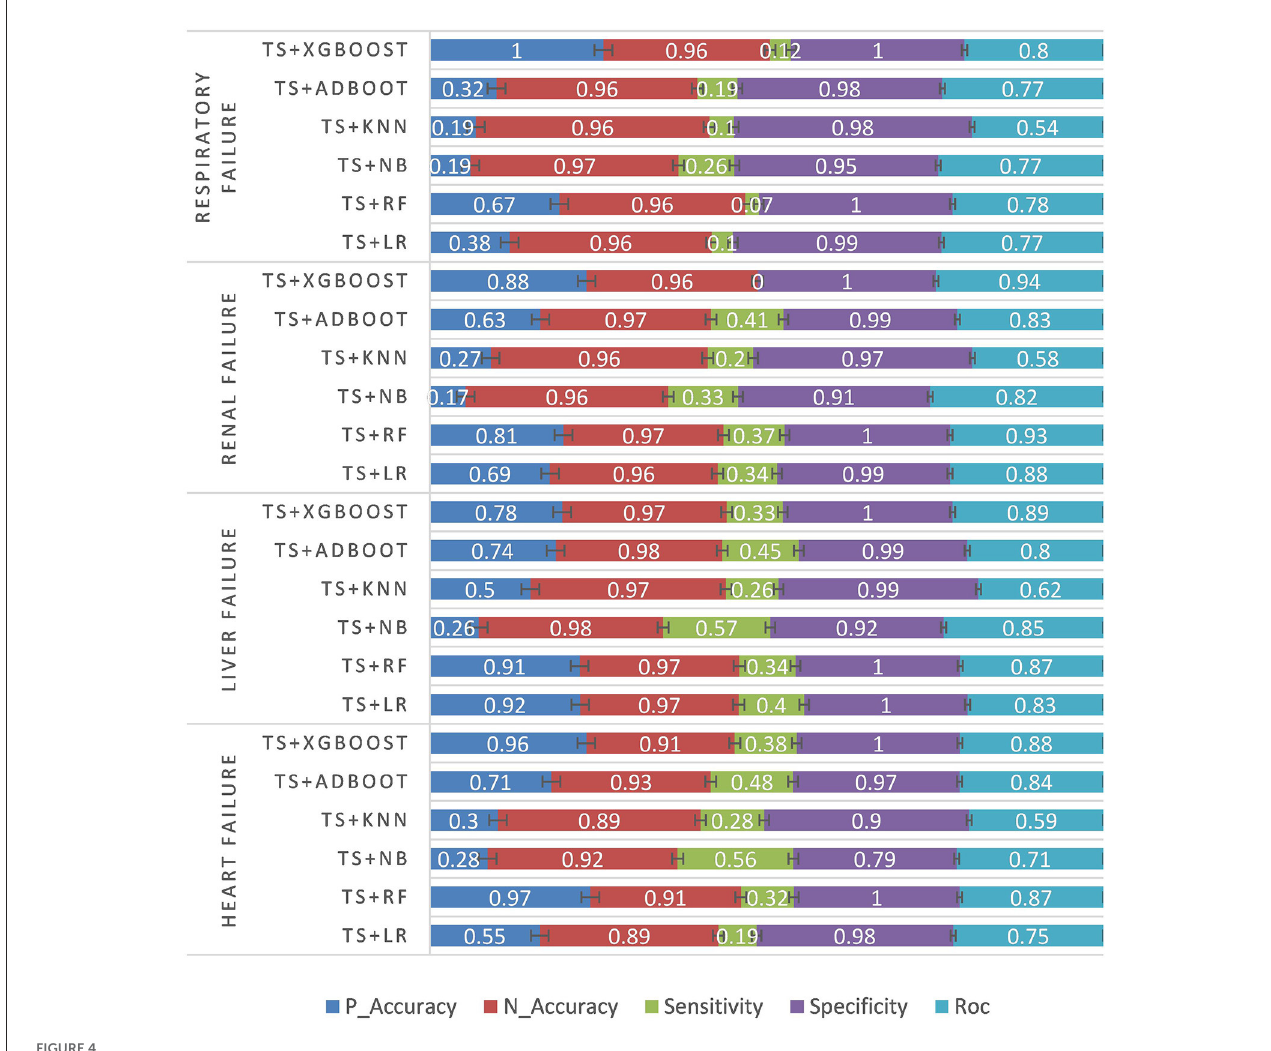
FIGURE4 Structured data experiment